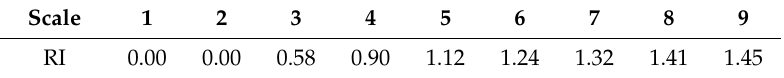
Table 7. Random index (RI) values for di ff erent